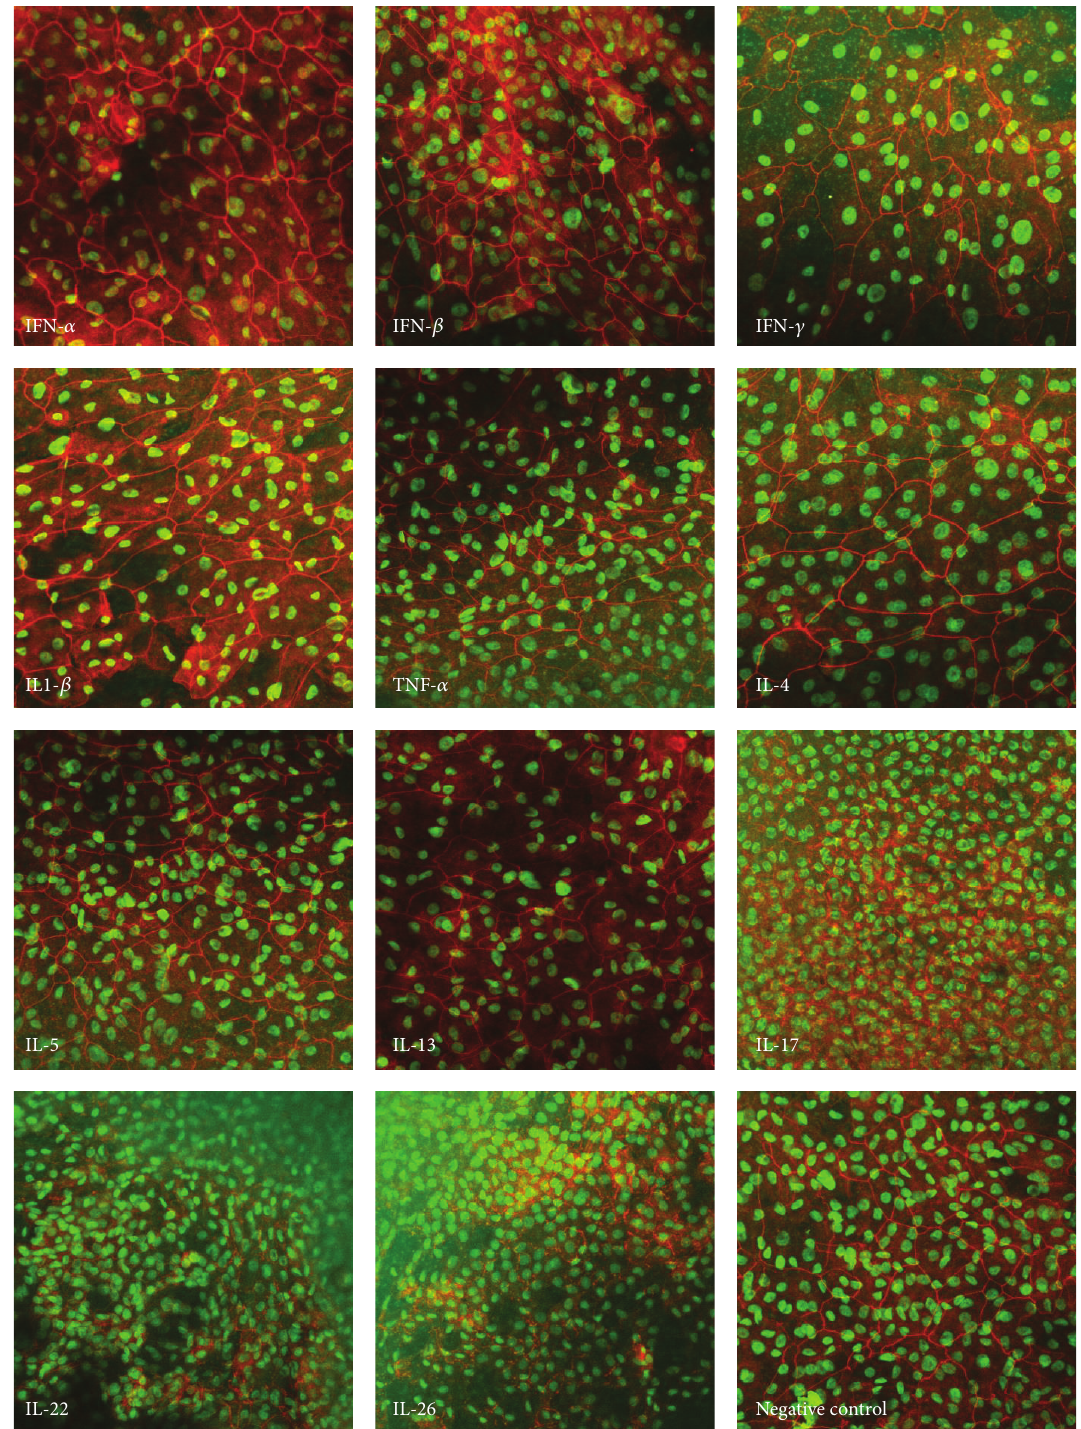
Figure 4: The Th17 cytokines cause a profound disruption of the tight junction in CRS. Effect of IFN- 𝛼 , IFN- 𝛽 , IFN- 𝛾 , IL-1 𝛽 , TNF- 𝛼 , IL-4, IL-5, IL-13, IL-17, IL-22, IL-26, and negative control on the localization of Zona Occludens-1 (ZO-1) (in red with DAPI stain in green) was imaged with 20x objective power using immunofluorescence confocal laser scanning microscopy 24 hours after application of the